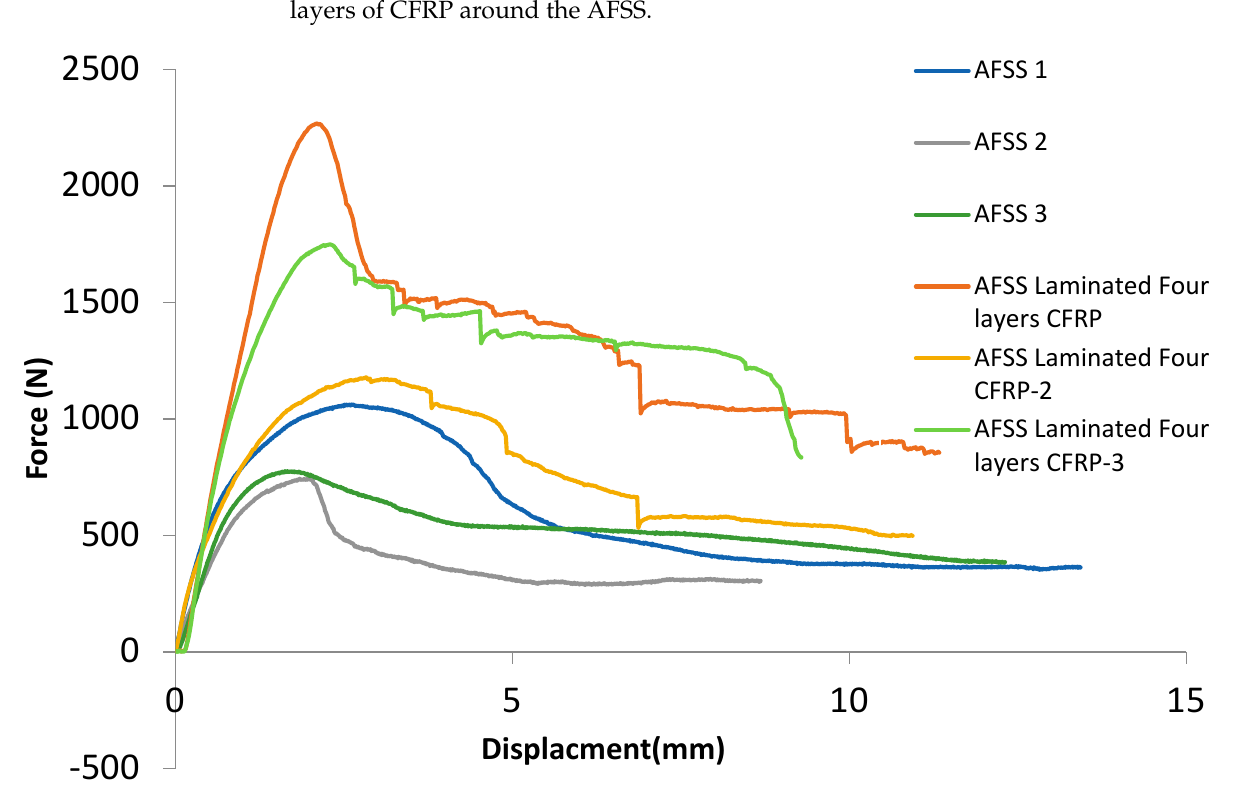
Figure 5. Load-displacement curved of AFSS and AFFSS with four layers CFRP.